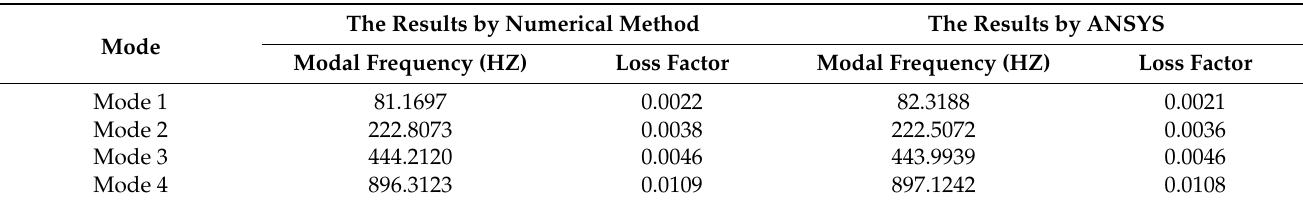
Table 2. Natural frequencies (Hz) and loss factors of the first three modes by two